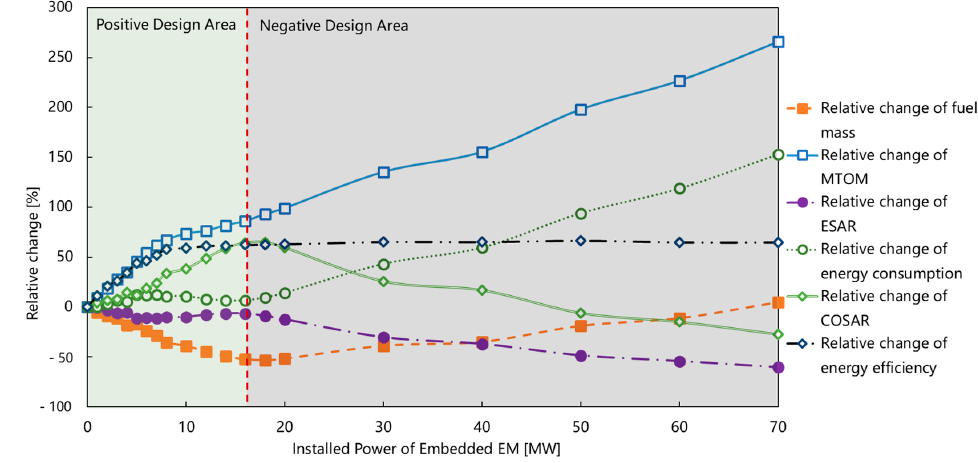
Figure 15. Relative change in energy consumption, energy efficiency, MTOM, fuel mass, COSAR, and energy specific air range (ESAR) with different levels of EM power.